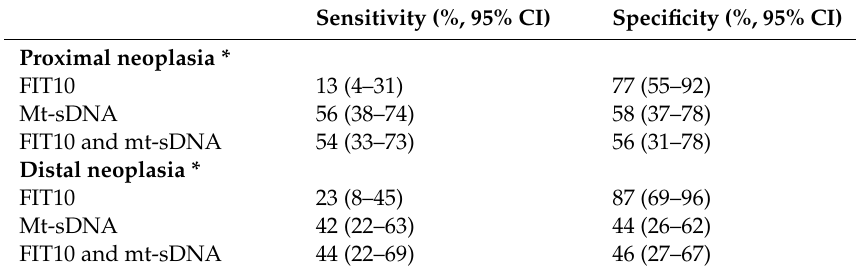
Table 5. Accuracy of fecal immunochemical test at cut-o ff of ≥ 10 µ g Hb / g feces (FIT10) and / or multi-target stool DNA test (mt-sDNA) according to location of most advanced